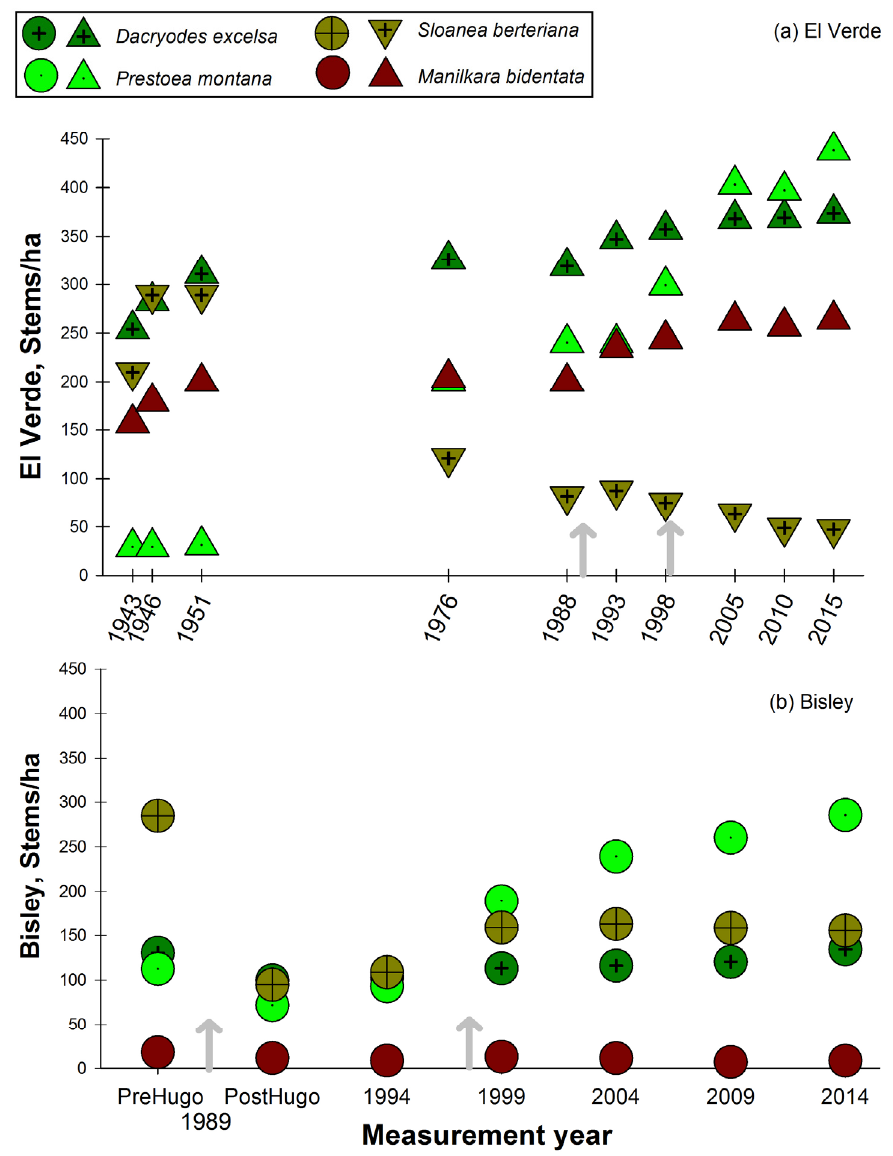
Figure 6. Stem density per each census year for selected shade tolerant/late successional species in two long-term research plots, Luquillo Experimental Forest, Puerto Rico. Panel ( a ) El Verde, with triangle symbols; panel ( b ) Bisley with circle symbols.